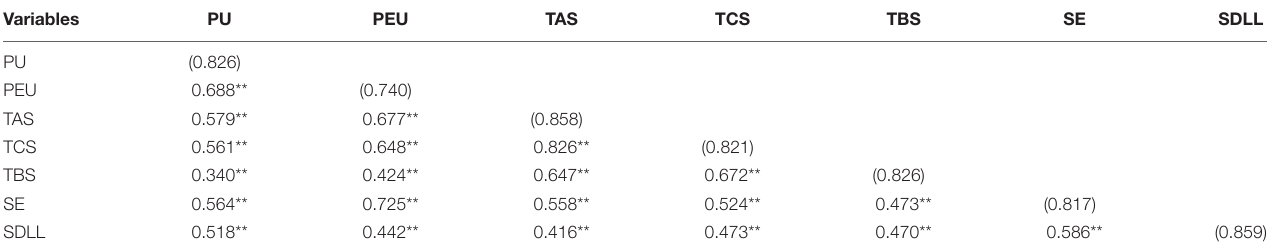
TABLE 2 | Correlations among study variables.